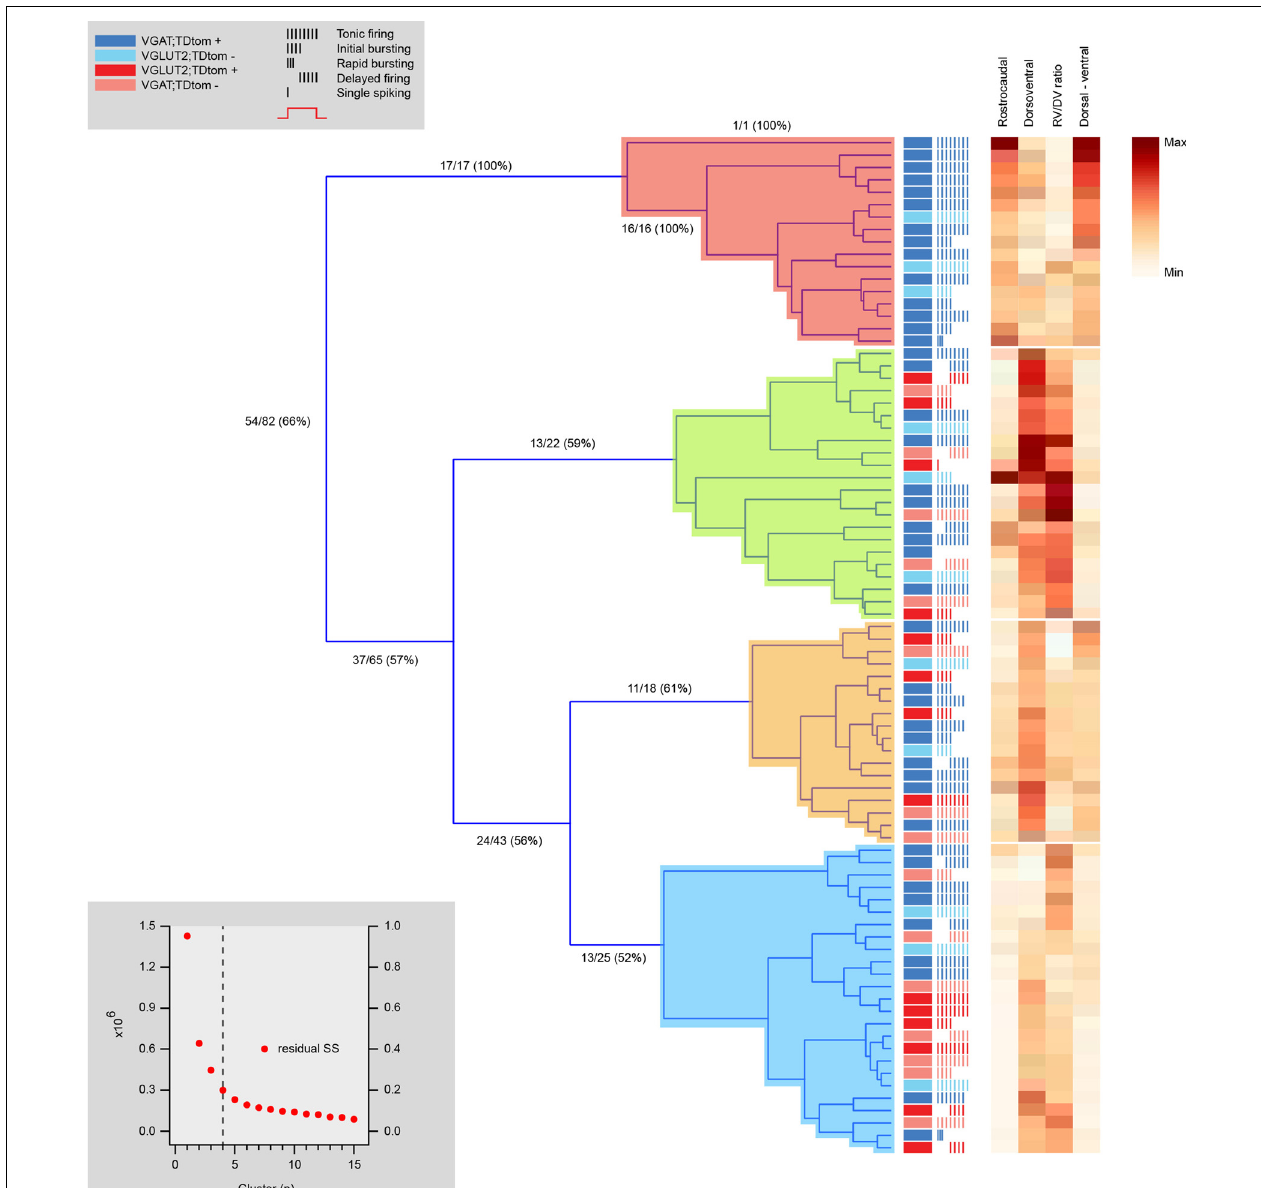
FIGURE 7 | Hierarchical cluster analysis of excitatory and inhibitory dorsal horn neurons on morphological attributes. Dendrogram and heatmap showing assignment of dorsal horn neurons into clusters based on morphological properties. The distribution of excitatory and inhibitory neurons, as well as each neuron’s AP discharge response pattern, are annotated using the key summarized in the upper left gray box, denoting neuron type and discharge pattern (inset). The number of clusters (four for this analysis) was assigned using a K-Means elbow method. This method plots the sum of squares error (SSE) for increasing cluster numbers to determine when adding additional clusters does not appreciably improve the SSE (lower gray box inset). One cluster contains a population of purely inhibitory interneurons with larger rostrocaudal dendritic dimensions (red). All remaining clusters include a mix of inhibitory and excitatory neurons (green, orange, and blue). Heat maps to the right highlight the relationship of four morphological characteristics to each cell cluster